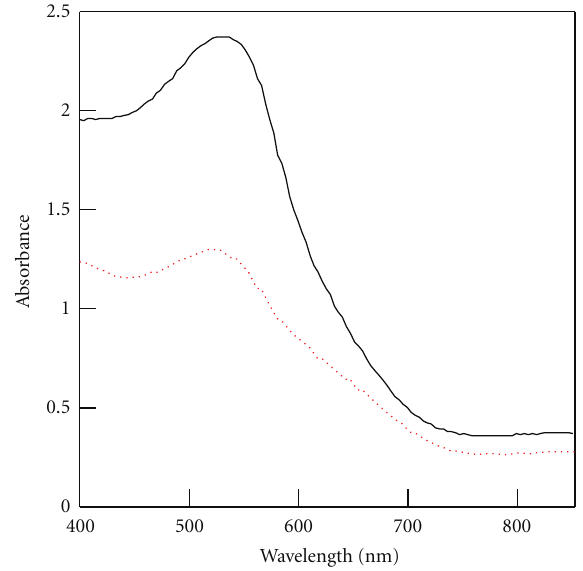
Figure 4: Absorbance spectra of nanocrystalline-TiO 2 electrodes with a sensitizing dye (N719): TiO 2 -BM paste (solid line) and TiO 2 - MG paste (dotted